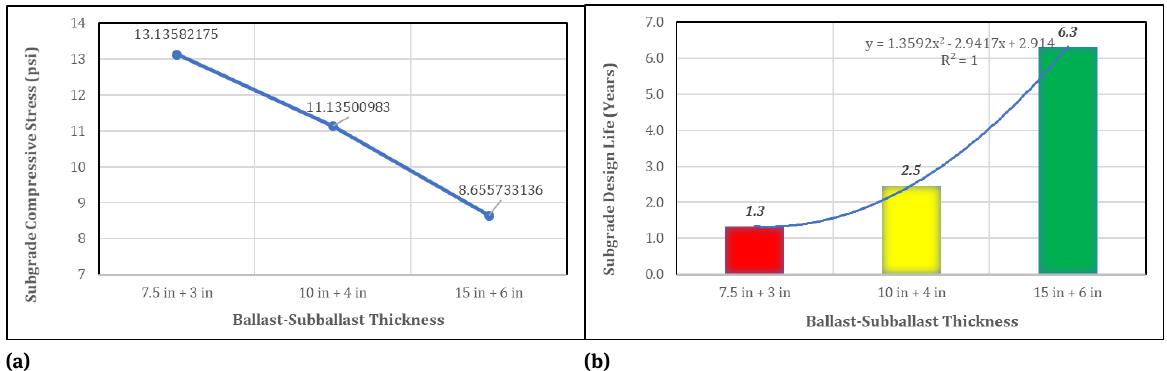
Figure 21: Influence of ballast and sub-ballast thickness on subgrade compressive stress (a) and on subgrade design life (b) in granular rail